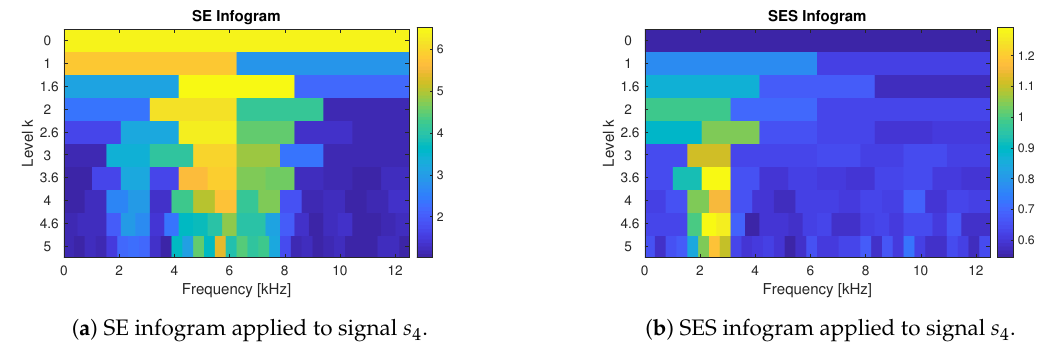
Figure 6. Results of the informative frequency band selection for signal s 4 using SE and Squared Envelope Spectrum (SES) inforgrams.